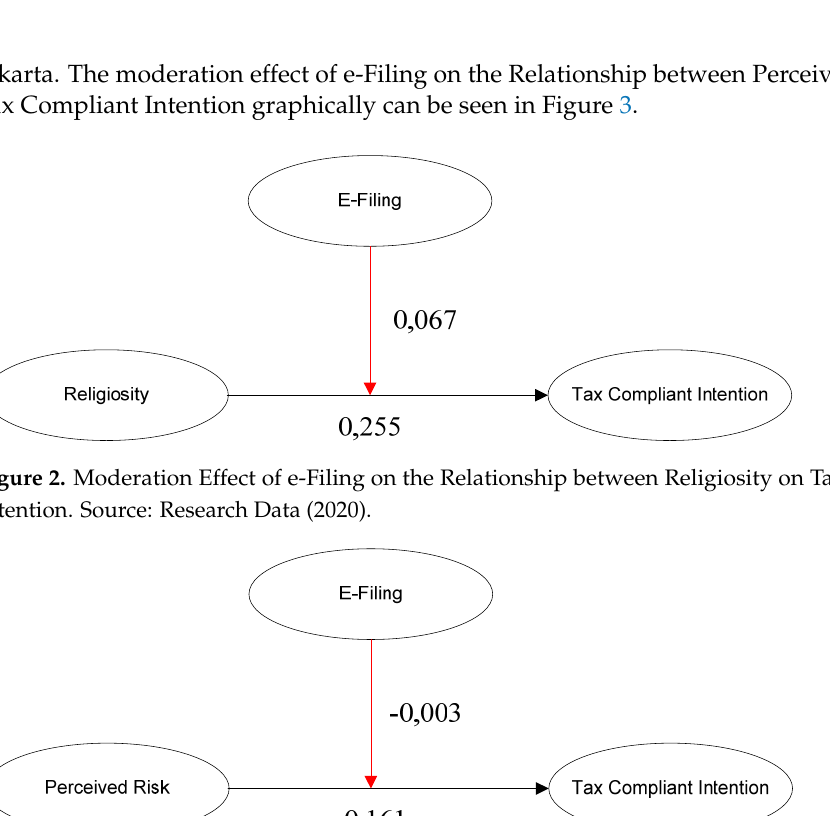
Figure 3. Moderation Effect of e-Filing on the Relationship between Perceived Risks on Tax Compliant Intention. Source: Research Data (2020).